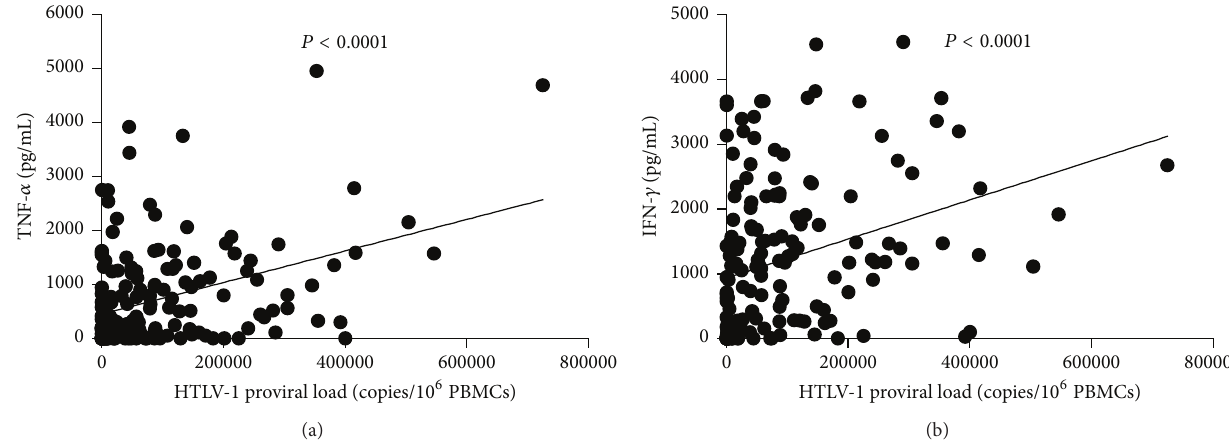
Figure 3: Correlation between proviral load and cytokine levels in HTLV-1 infected subjects. There was a direct correlation between proviral load and TNF- 𝛼 levels (a) and between proviral load and IFN- 𝛾 levels (b) when data from all participants of the study were analyzed.